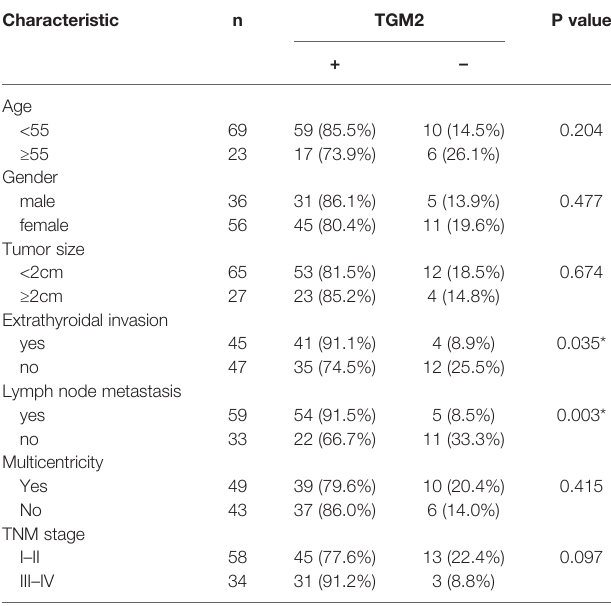
TABLE 1 | Correlation between TGM2 expression and clinicopathological features in patients with papillary thyroid cancer (n = 92). Characteristic n